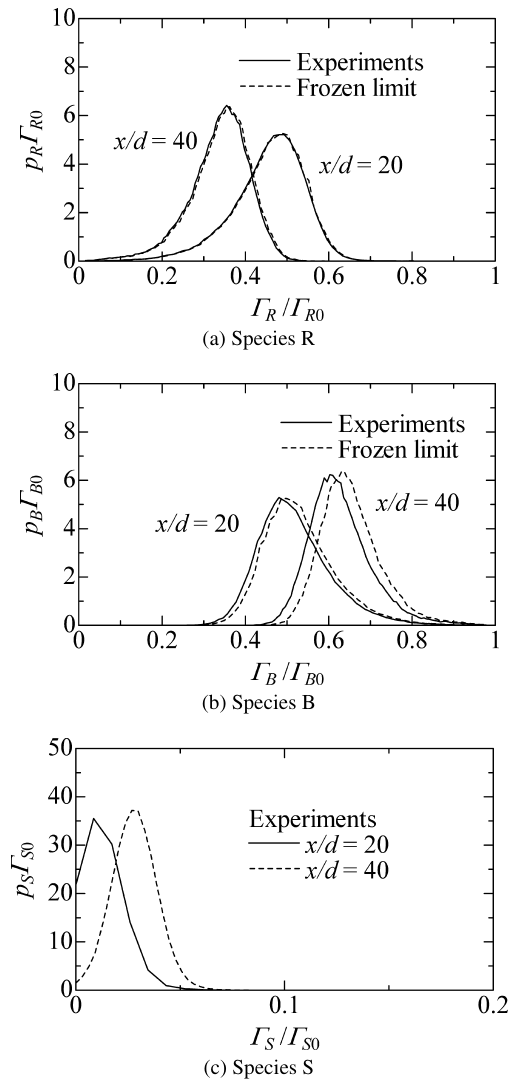
Fig. 8 Downstream changes in concentration PDF along the jet centerline.